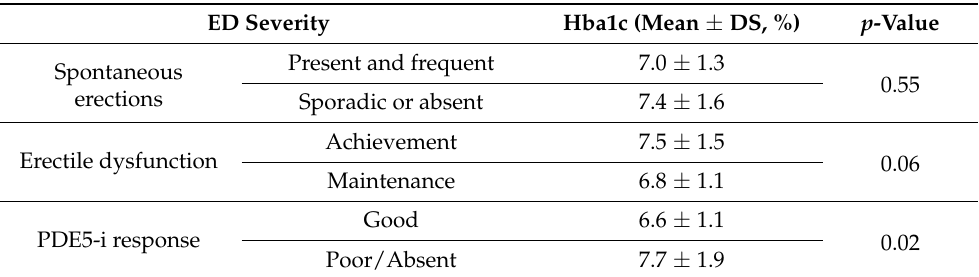
Table 2. Comparison of Hba1c and ED severity in Group A. ED Severity Spontaneous